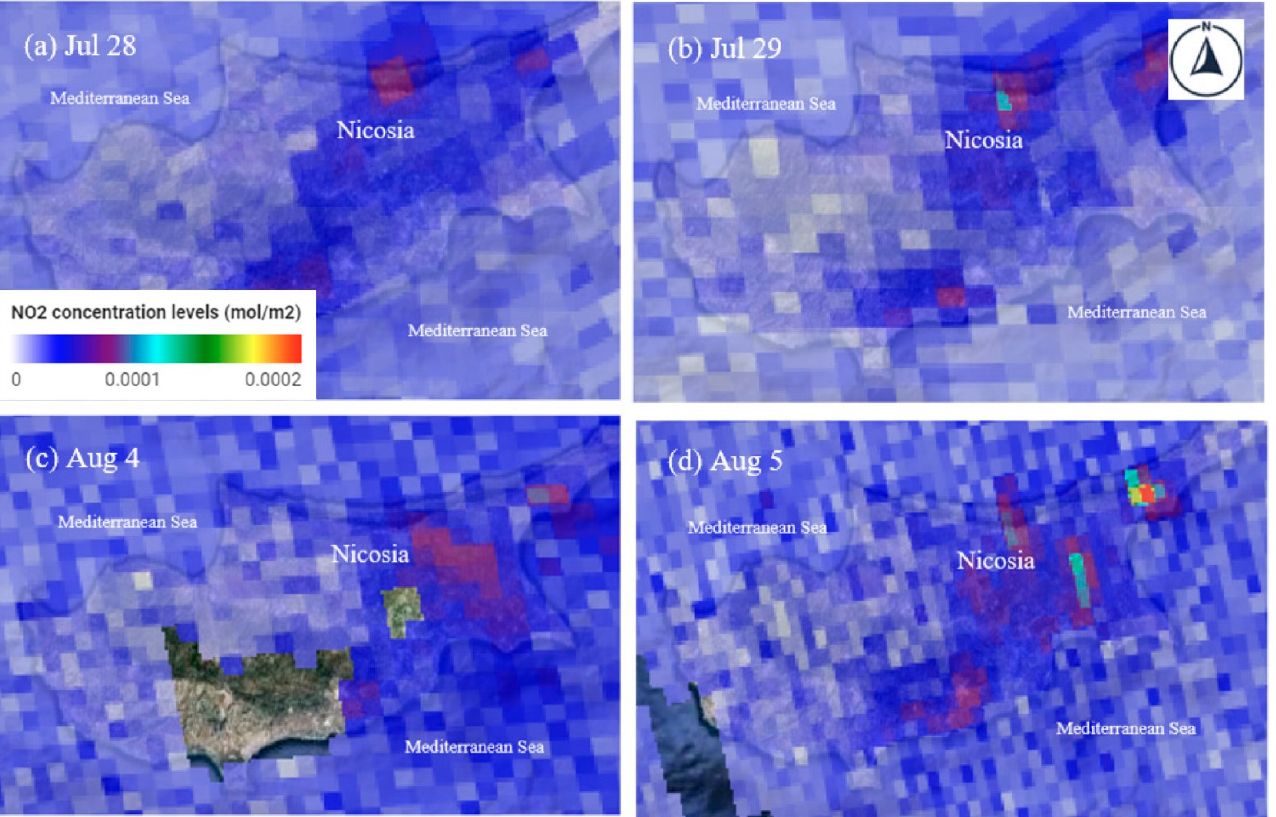
Figure 7. NO 2 concentrations over Nicosia, Cyprus 28 July–5 August 2020.